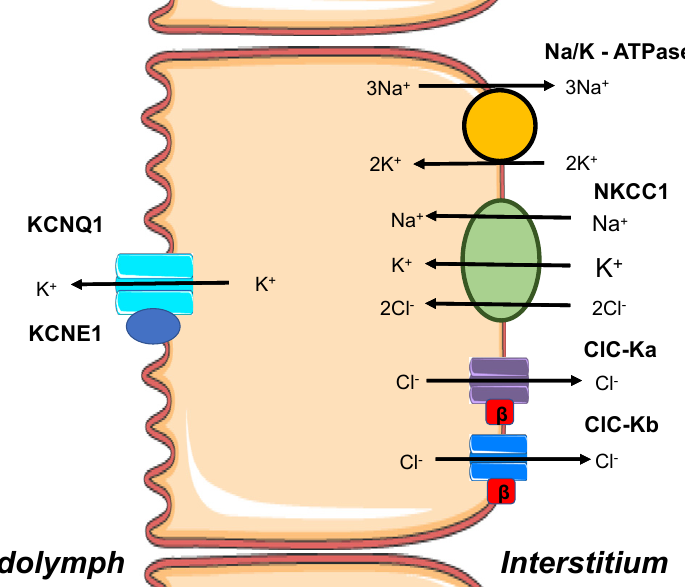
Figure 2. Chloride channels’ expression in the inner ear. In strial marginal cells, basolateral ClC-Ka (dark violet) and ClC-Kb (blue) together with their auxiliary subunit β -barttin (red) recycle Cl − . Loss of barttin or loss of both isoforms of chloride channels causes deafness (Bartter Syndrome type IV).